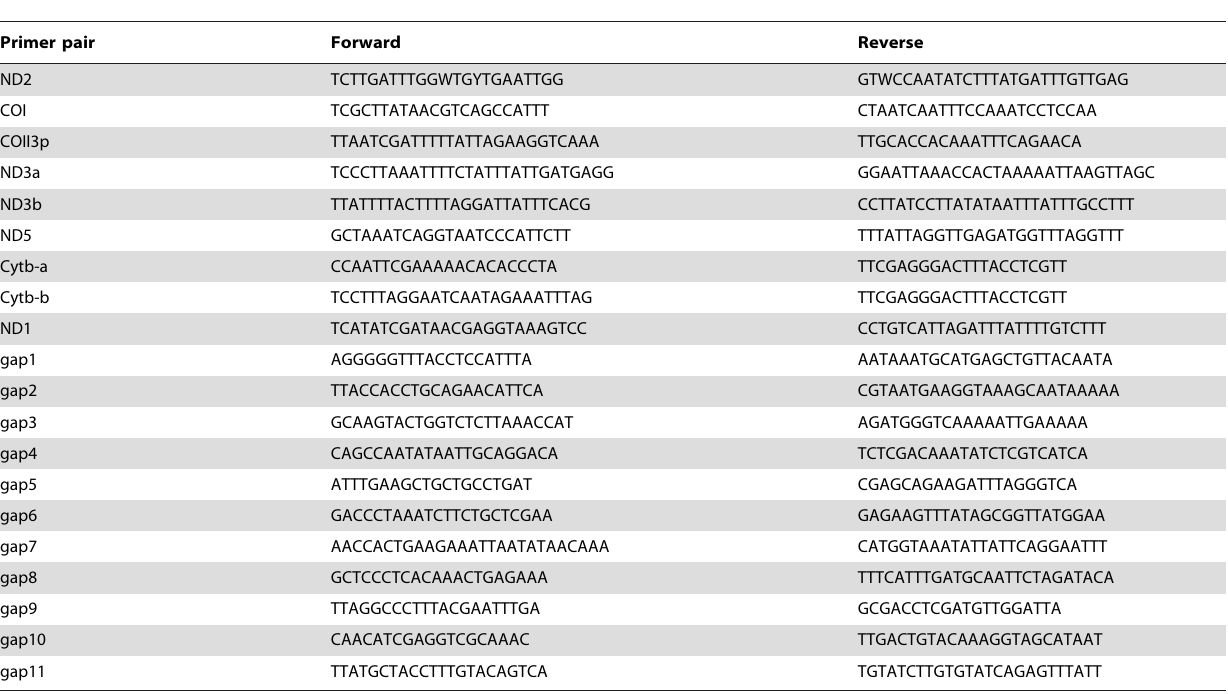
Table 1. Oligonucleotide primers used for amplification of overlapping fragments used to reconstruct the M. vitrata mitochondrial genome sequence (Fig.